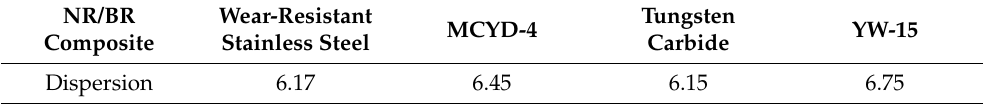
Figure 6. Tensile strength and tear strength of NR/BR composites after friction with different met- als.